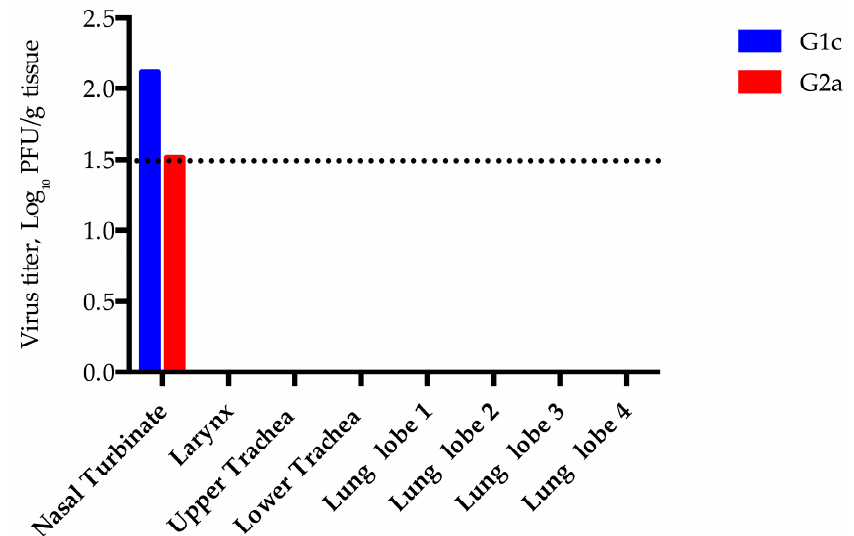
Figure 2. MERS-CoV viral load in goats experimentally infected. Tissues from goat kids 1c and 2a were collected at necropsy 5 days post-infection and viral load was determined by plaque assay of tissue homogenates. The limit of detection for this assay is 1.5 log 10 PFU/g, indicated by the dashed line.